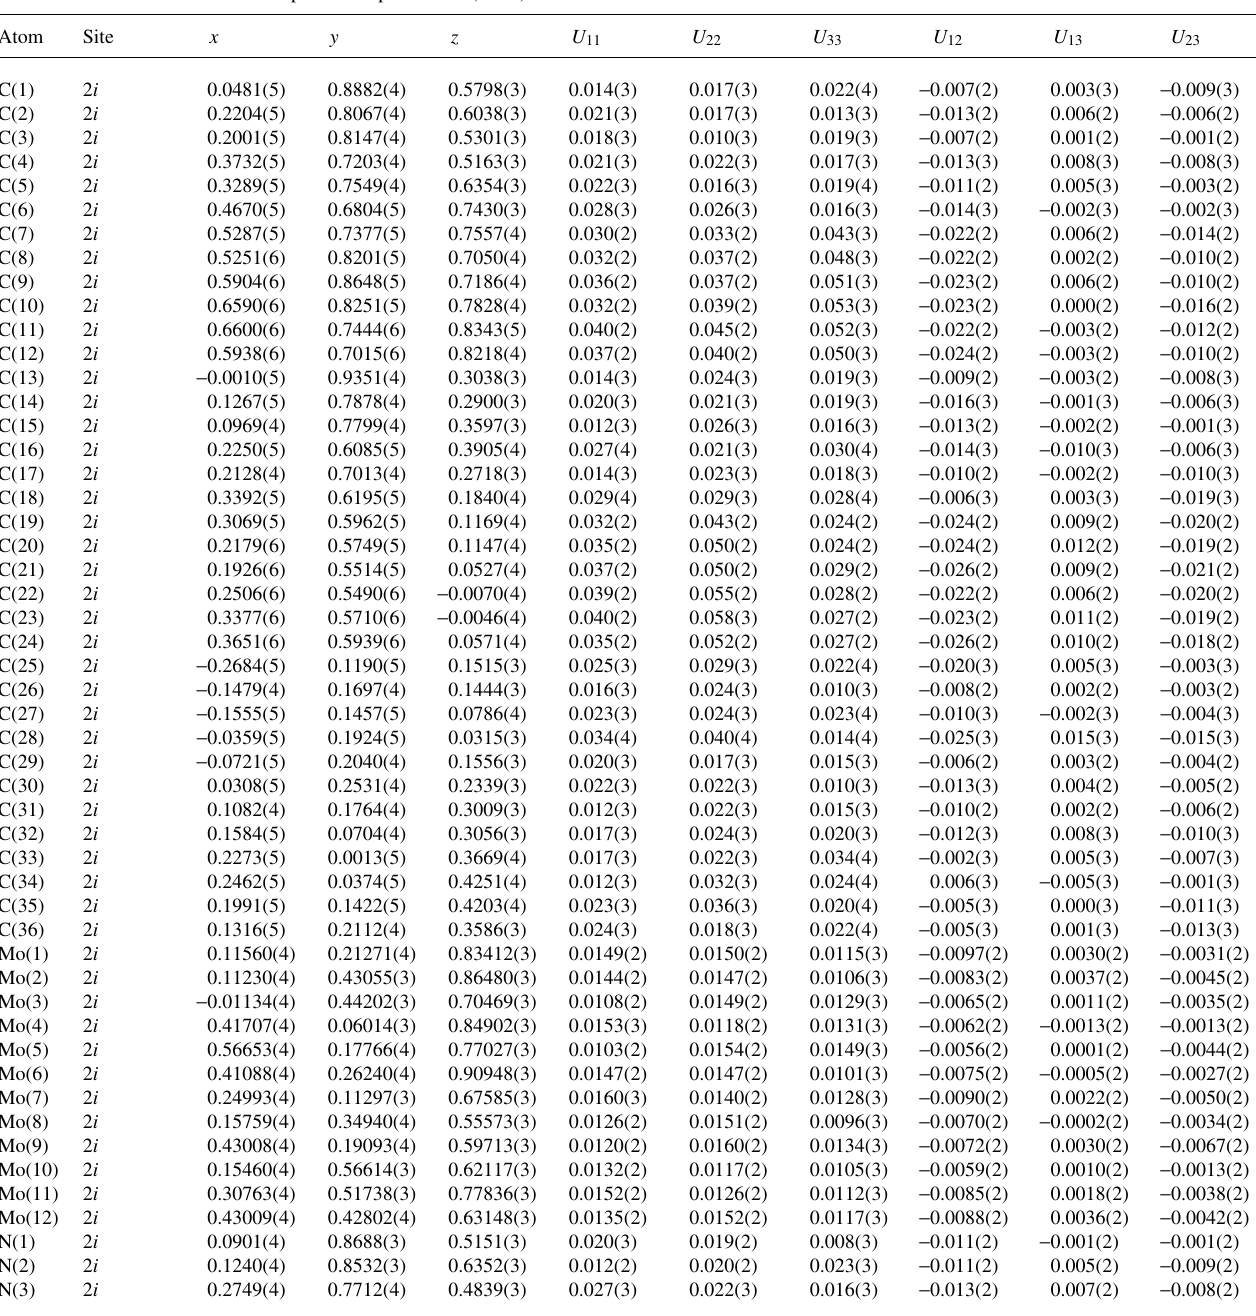
Table 3. Atomic coordinates and displacement parameters (in Å 2 )